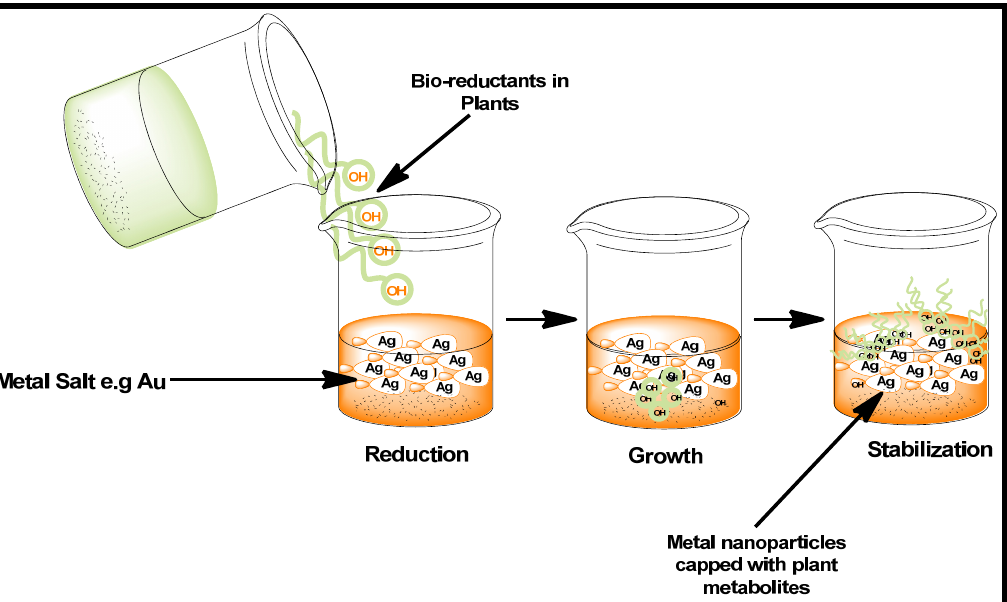
Figure 3. Green synthesis scheme for Au, Ag, and Au–Ag nanoparticles. Redrawn from [50], with permission from Elsevier (Copyright 2022).